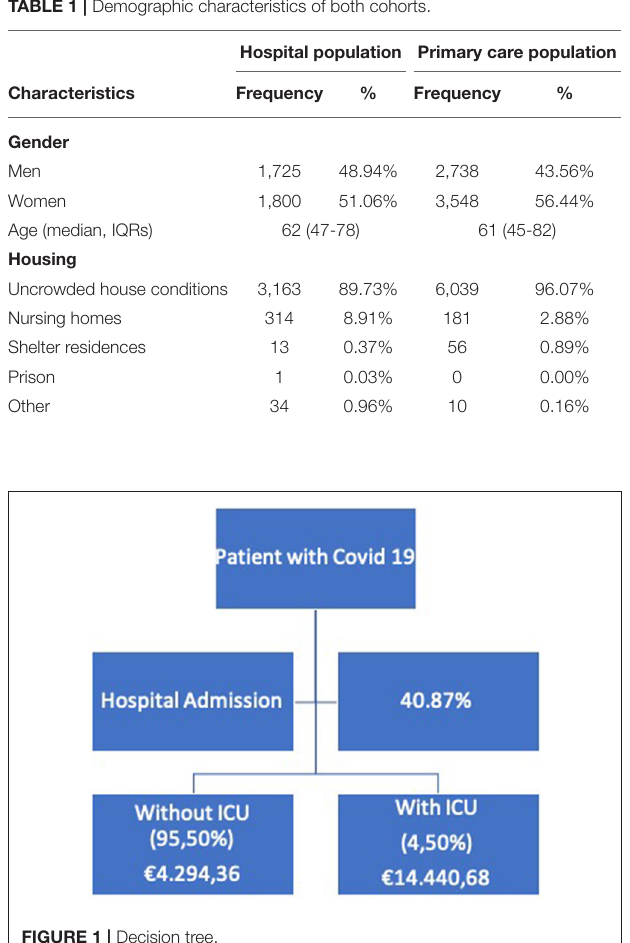
FIGURE 1 | Decision tree.